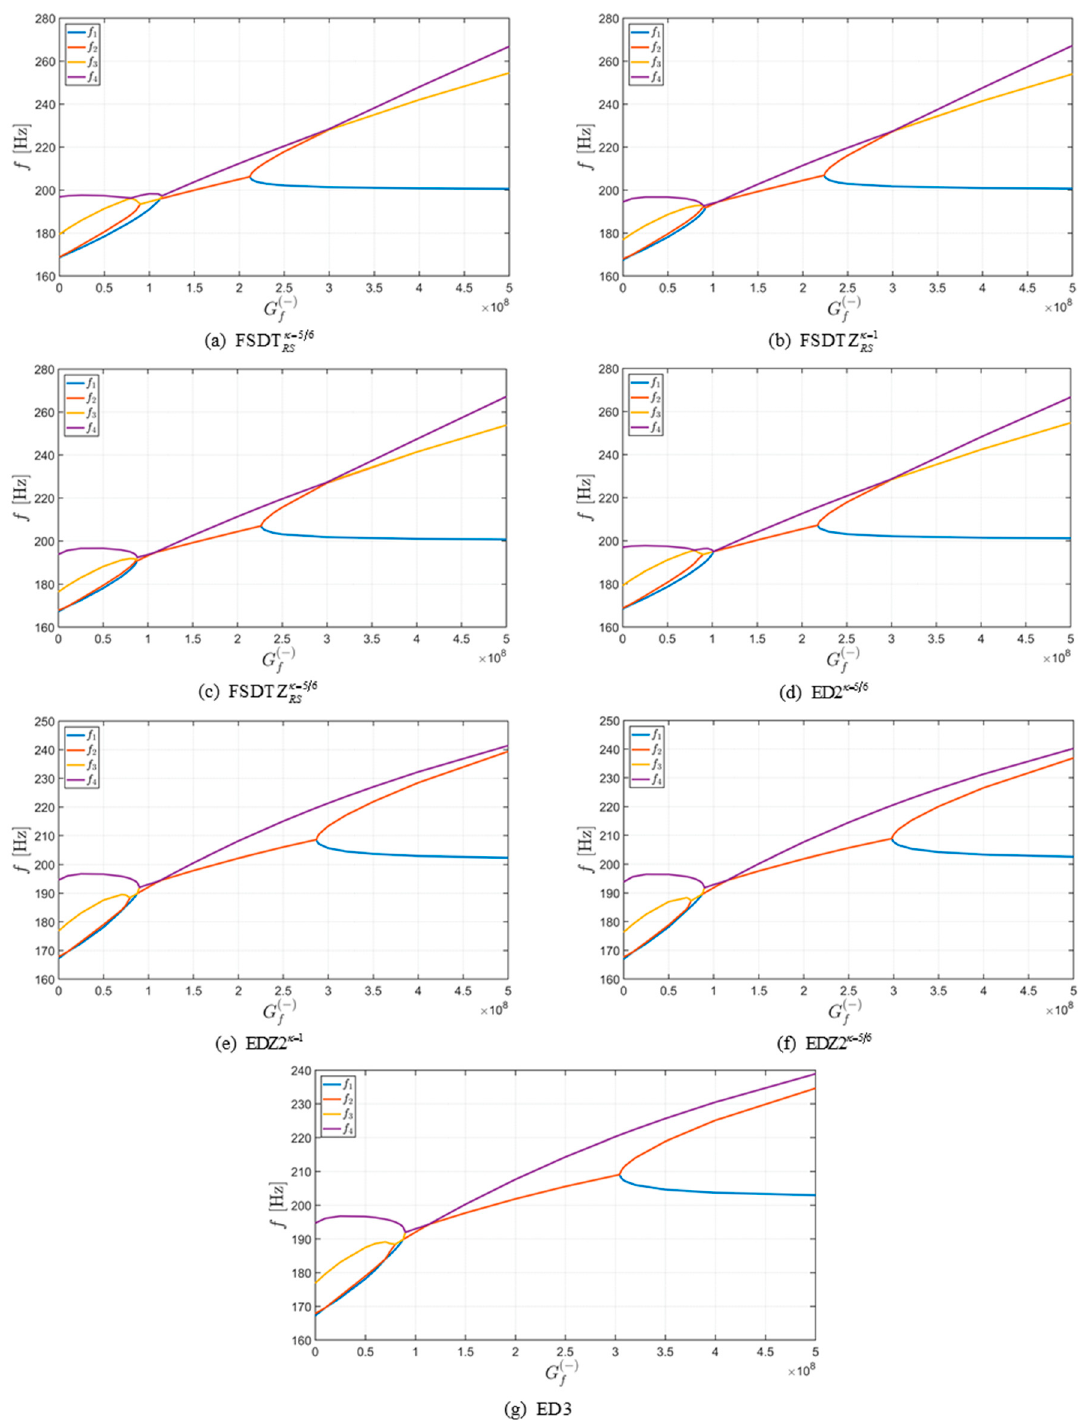
Figure 11. First four frequency modes of a CFCF cylindrical surface (Figure 4b) reinforced by CNTs distributed as in Figure 5b for the different theories: ( a ) FSDT κ = 5/6 ( d ) ED2 κ = 5/6 ; ( e ) EDZ2 κ = 1 ; ( f ) EDZ2 κ = 5/6 ; ( g ) ED3. The mass fraction was w r = 0.25, and the agglomeration parameters µ 1 = 0.5 and µ 2 = 0.75. The Chebyshev-Gauss-Lobatto grid distribution was employed, with I N = I M =